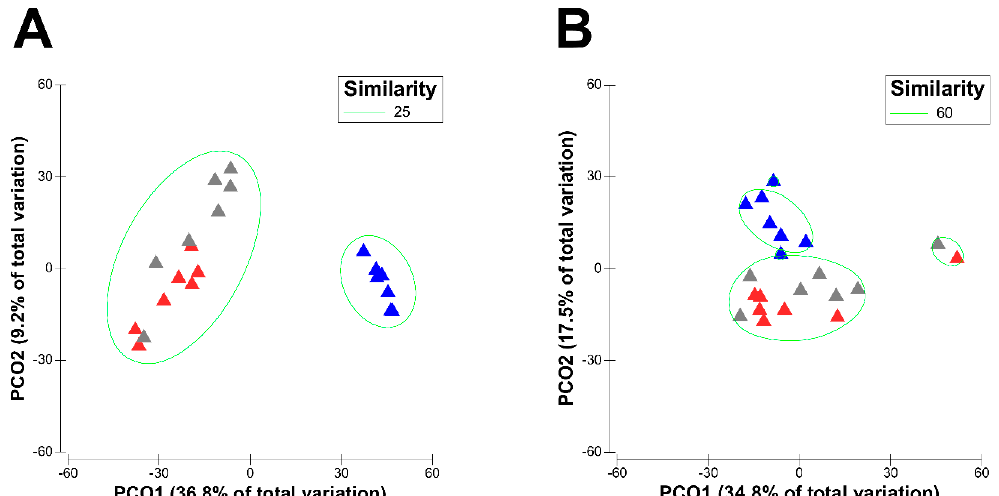
Figure 1. Principal-coordinate analysis (PCO) of the active rumen bacterial ( A ) and eukaryotic ( B ) communities during different physiological stages. The bacterial OTU abundance data were normalized by total sum normalization, while eukaryotic OTU abundance data were transformed by Hellinger transformation (total sum normalization combined with square root transformation) prior to the calculation of Bray–Curtis dissimilarity matrices. The three physiological stages are indicated by different colored triangles: red triangles, LL; blue triangles, DP; grey triangles, PP. The LL and PP is a major cluster with 25% similarity in the bacterial dataset, and with 60% similarity in the eukaryotic dataset.